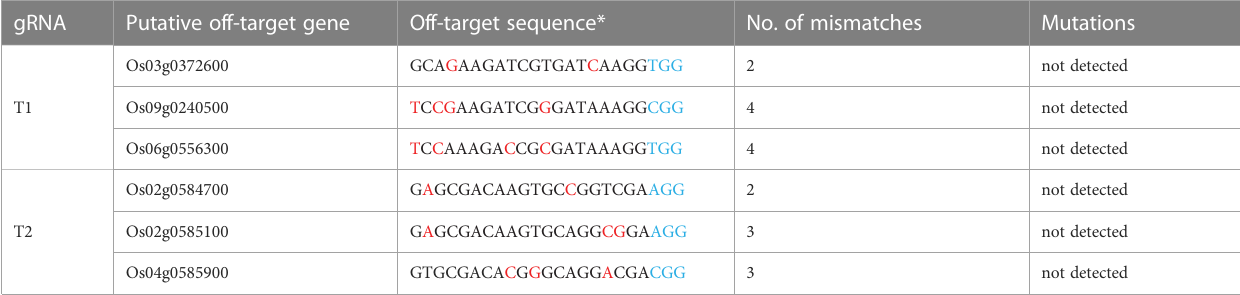
TABLE 1 Mutations detected in the putative CRISPR/Cas9 off-target sites. gRNA Putative off-target gene Off-target